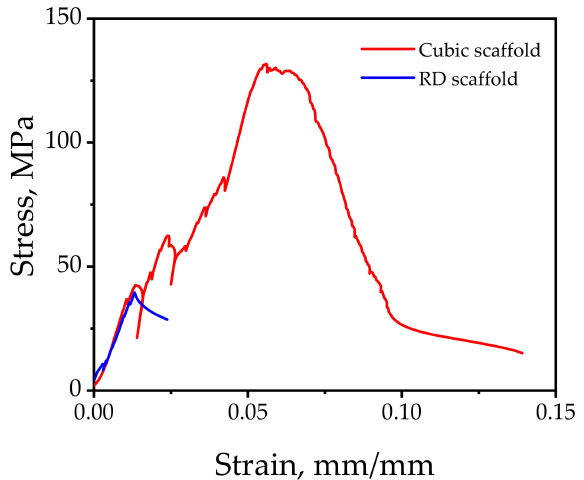
Figure 7. The engineering compressive stress–strain curves of the cubic and rhombic dodecahedron (RD) W scaffolds.